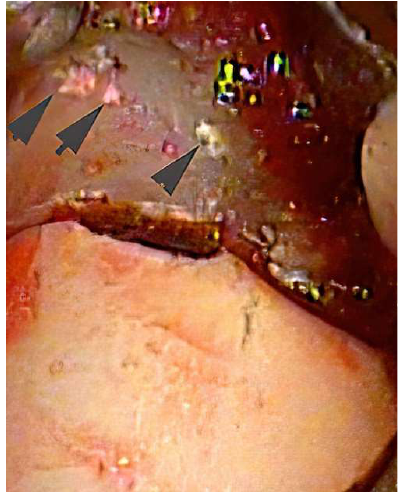
Figure 2. During videoscope assisted minimally invasive surgery (VMIS), multiple areas of residual calculus (arrows) are noted to remain after SRP. The position of the calculus is in an area of deep pocket probing depth and would be very difficult to access during blind SRP. (Videoscope photo 40× magnification).